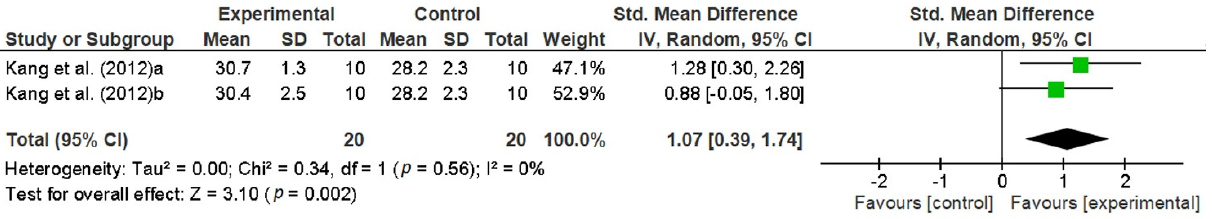
Figure 4. Pooled standardized mean differences and overall effect size (95% CI) on the FRT test immediately after the intervention. (a) Treadmill with optic flow versus control group. (b) Treadmill group versus control group.